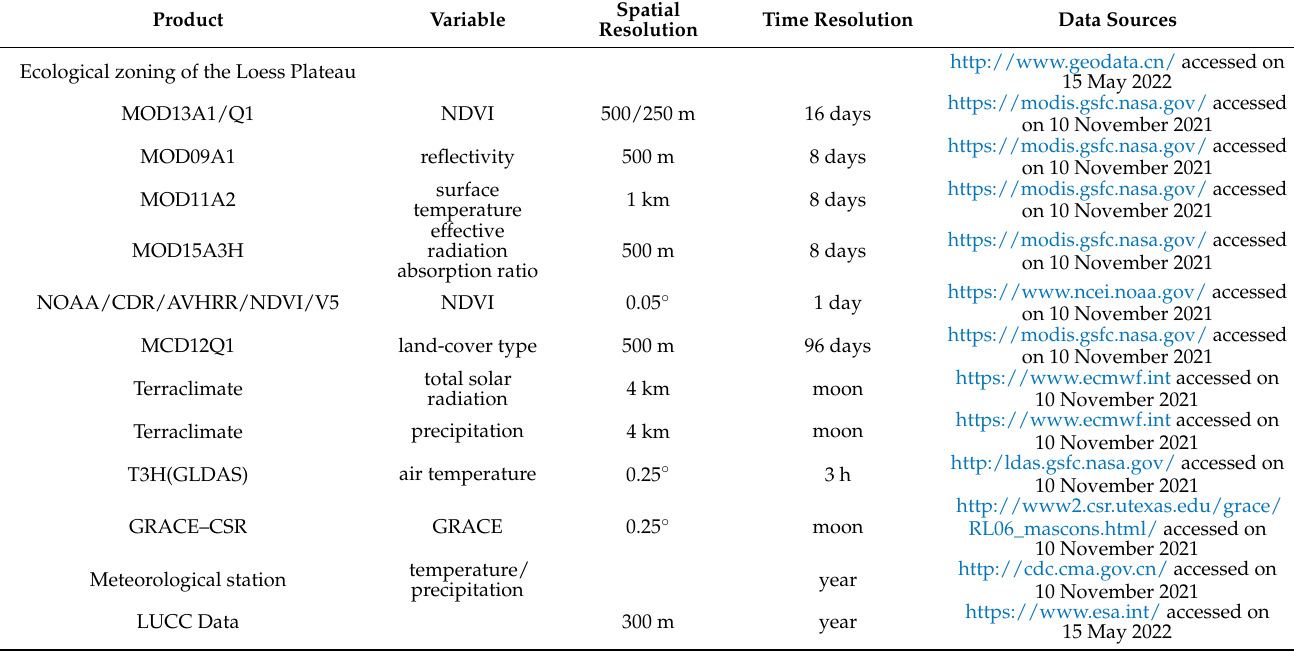
Table 1. Data types and sources used in this